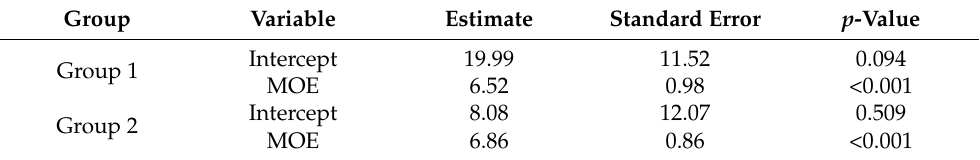
Table 17. Estimates for regression models of MOR with MOE, Group as the predictor and MOE * Group interaction term. Variable Estimate Standard Error p -Value Intercept